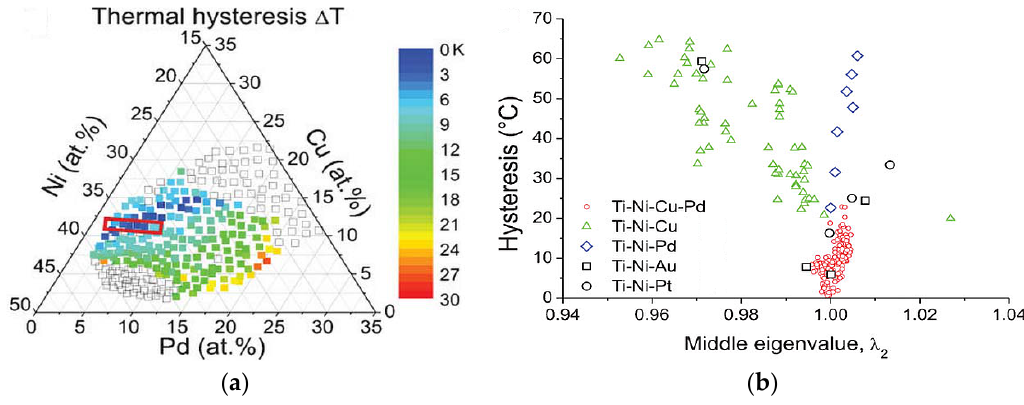
Figure 12. ( a ) Δ T values on a pseudoternary projection of the quaternary composition tetrahedron with the red box highlighting compositions for which Δ T approached zero; ( b ) thermal hysteresis values in Ti–Ni ‐ based ternary and quaternary shape memory alloys [116], with copyright permission from © IOP Publishing .